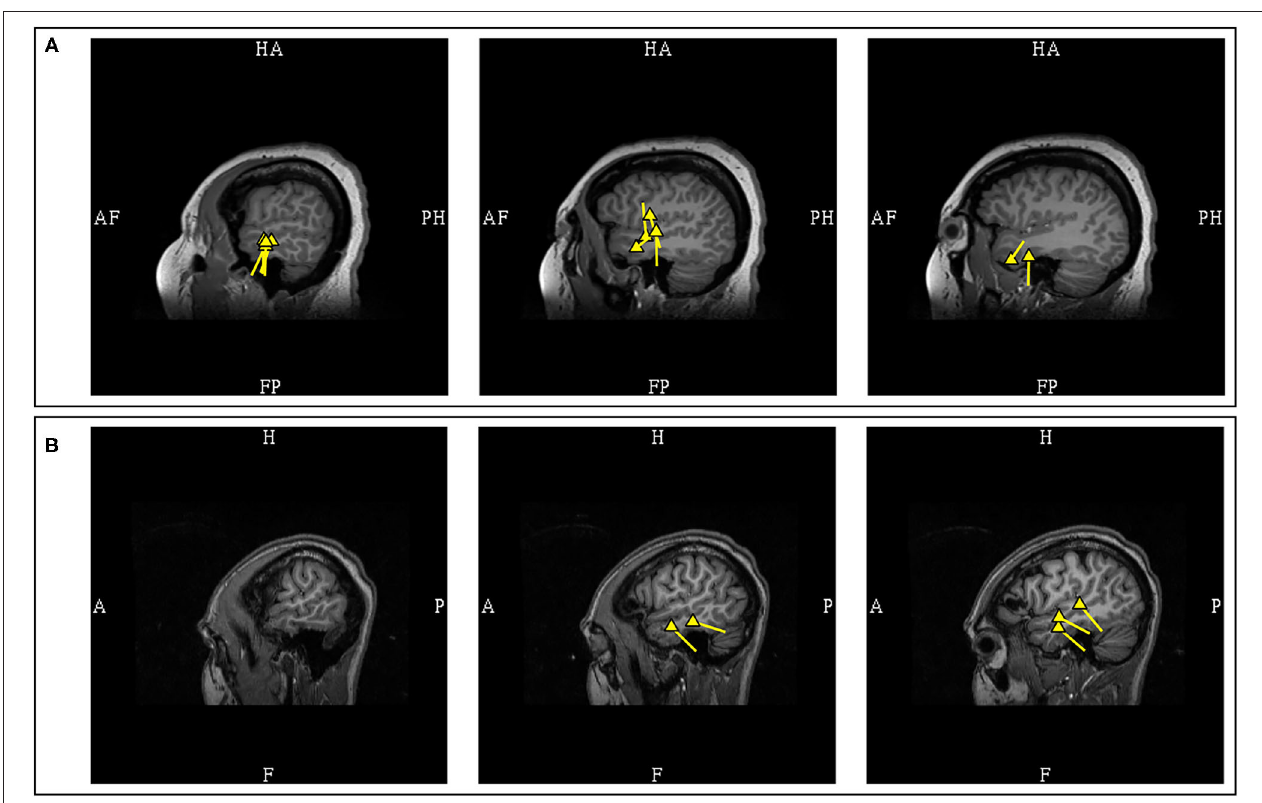
FIGURE 8 | MEG-MRI coregistration summary in two patients with temporal dipoles. (A) Frequent anterior temporal dipoles were suggestive of anterior temporal source. Imaging review revealed temporal tip encephalocele. (B) Temporal dipoles broadly distributed over anterior and posterior temporal region provides comparatively limited suggestion of seizure onset in the absence of a lateral temporal